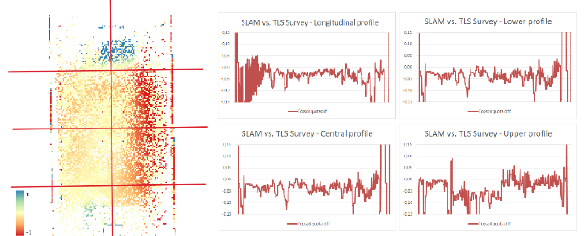
Figure 14 . Topsoil quota differences between SLAM and TLS surveys. Left: raster difference and sections, right: quota differences’